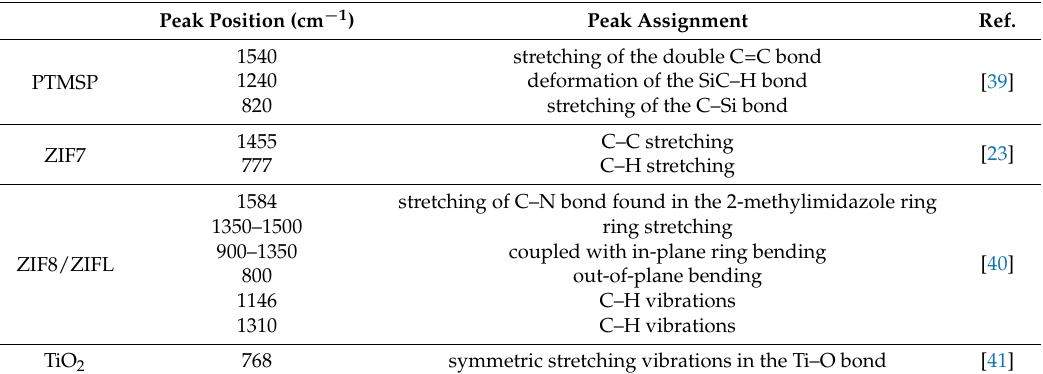
Table 1. Detailed peak assignment of PTMSP and various